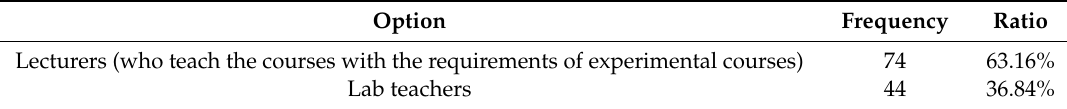
Table 4. Descriptive statistical analysis of teachers’ basic information.